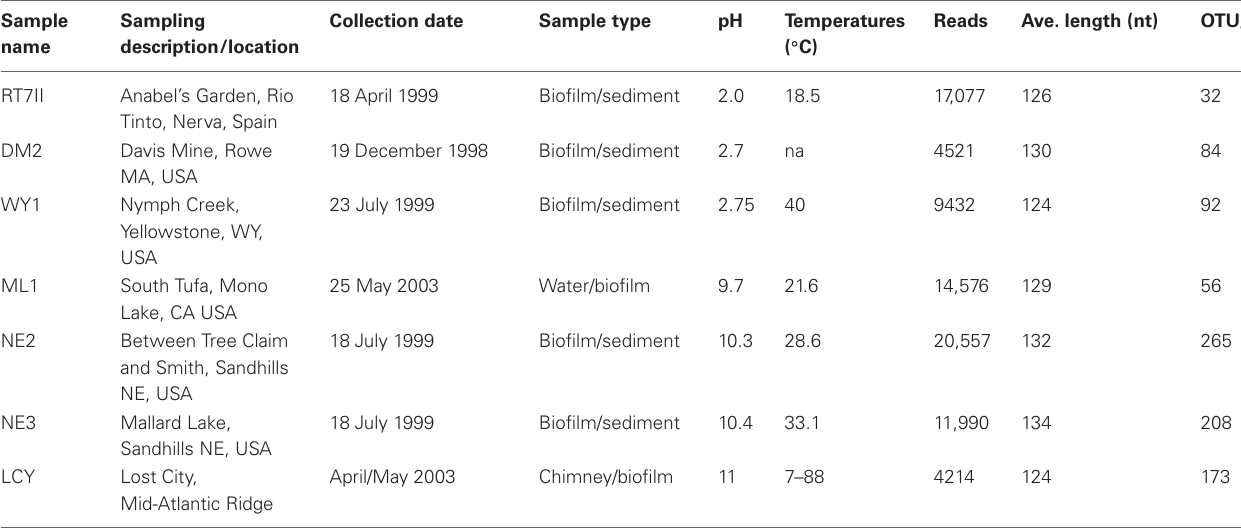
Table 1 | Metadata and contextual data associated with the samples used in this study. Sample